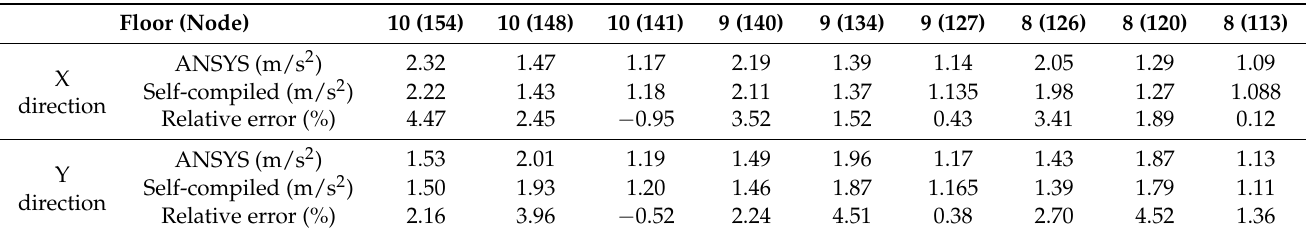
Table 4. Contrasts of the maximum acceleration of the nodes between the self-compiled program and the ANSYS